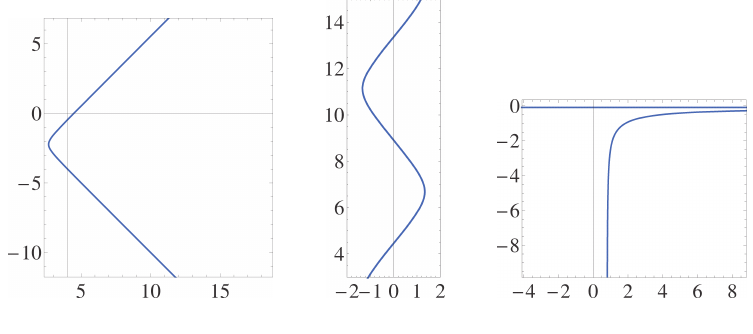
Fig. 1. The left figure is obtained by formulas (25) with a D 2 and c D 1 , this one in the middle via formulas (27) with a D 3 and c D 1 , and that one at most right by formulas (32) with a D 1 and c D 2 . In all these cases (cid:27) (cid:17) 2